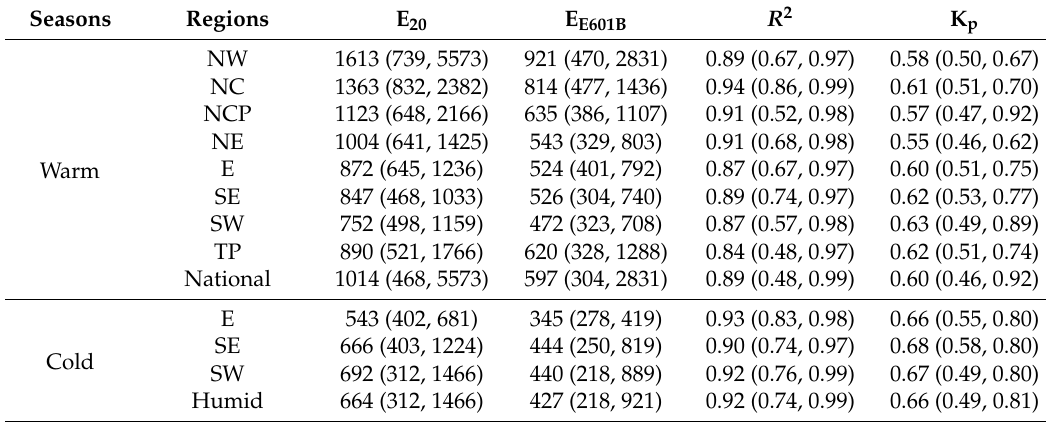
Table 3. Statistical information regarding E601B and φ 20 pan evaporation (E E601B , E 20 ), the determination coefficient ( R 2 ), and the conversion coefficient (K p ) between the two pans in eight climatic regions during the warm season and three regions in the cold season. The minimum and maximum values are given in parentheses.